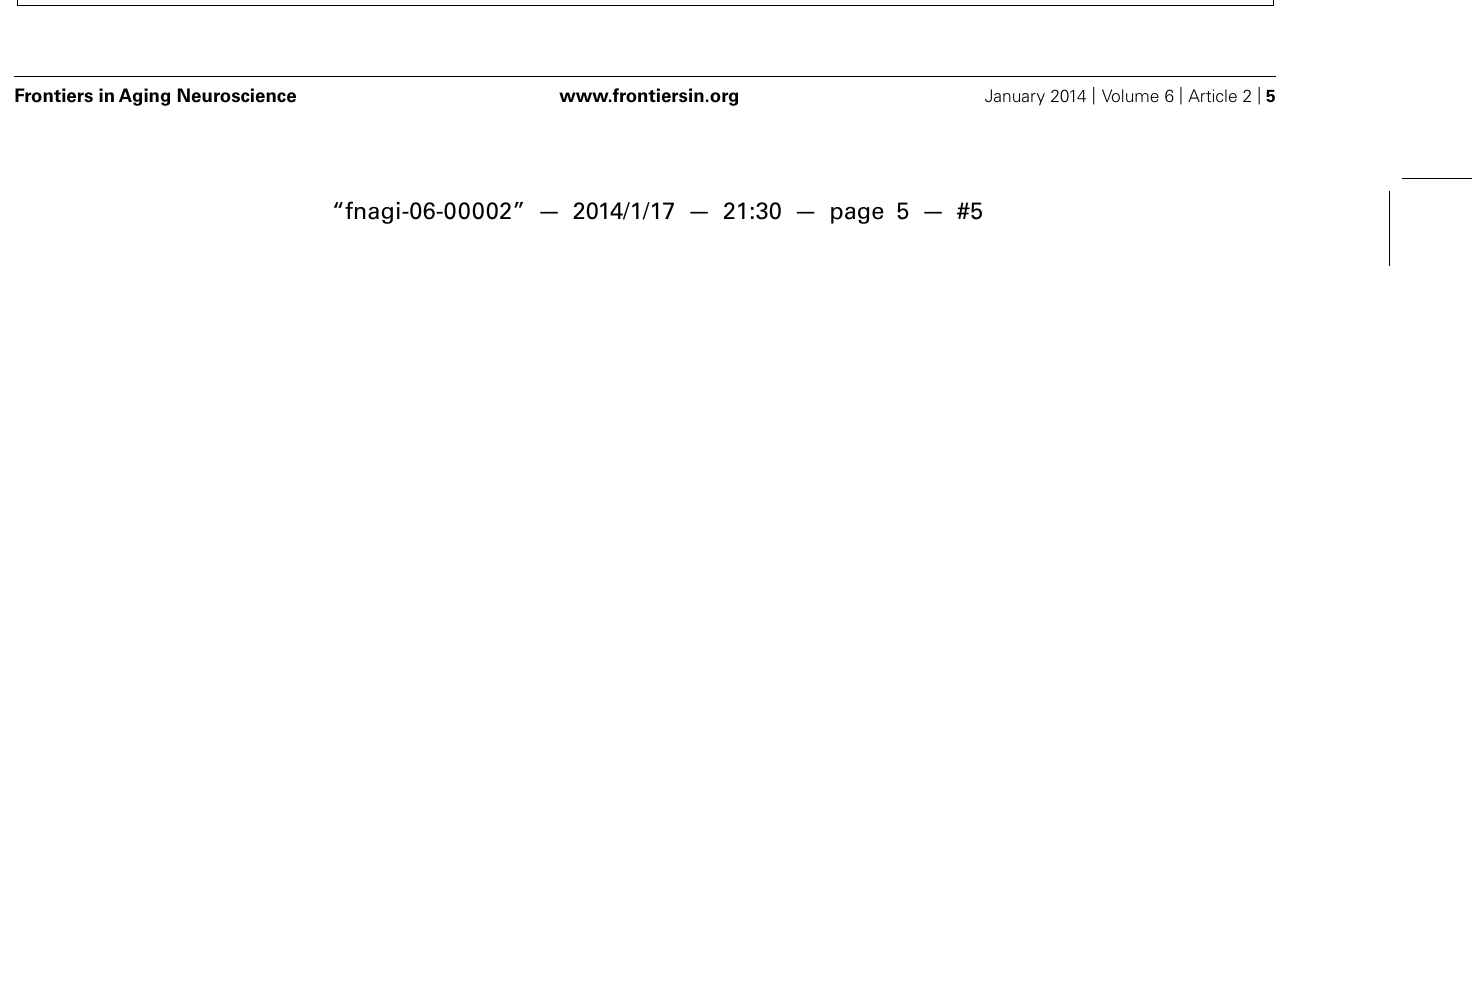
FIGURE 4 | Mean path length to find the escape platform during spatial discrimination training conducted 10 days following the initial episode of spatial training. The mean distance traveled ( ± SEM) per training block in the spatial discrimination task for young (A) , middle-age (B) , and aged (C) rats trained for reference memory (open circles, n = 10/11/16, young/Mid Age/